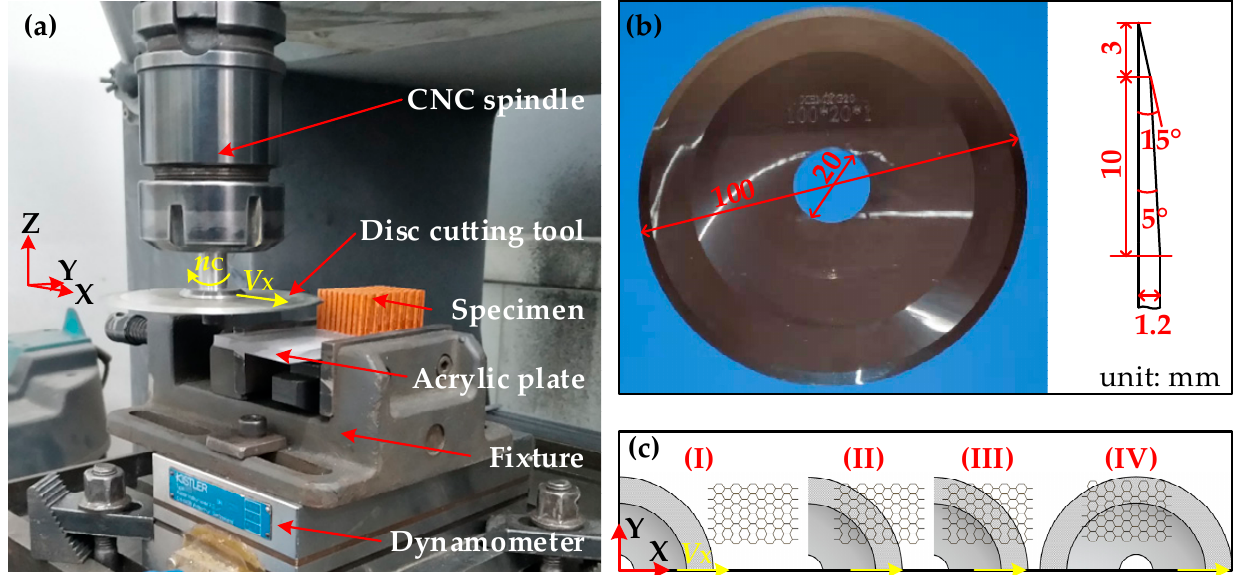
Figure 3. Experimental set-up and cutting process: ( a ) experimental set-up; ( b ) disc cutting tool; ( c ) cutting process of the honeycomb.